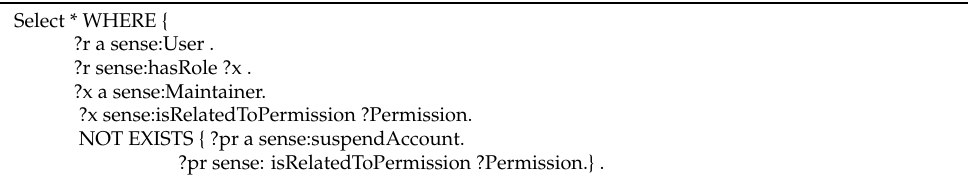
Table 9. SPARQL Query—ATM use case.